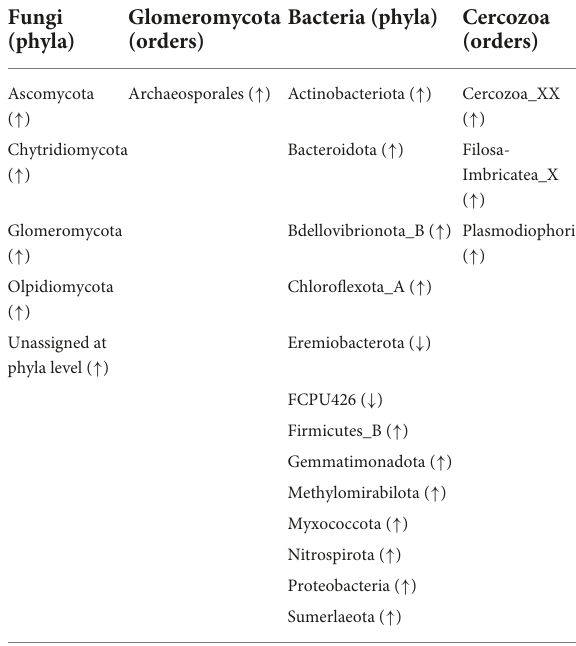
TABLE 2 Microbial taxonomic groups for which urbanity [principal component analysis (PCA) axis 1] was identified as the key explanatory variable for shifts in OTU